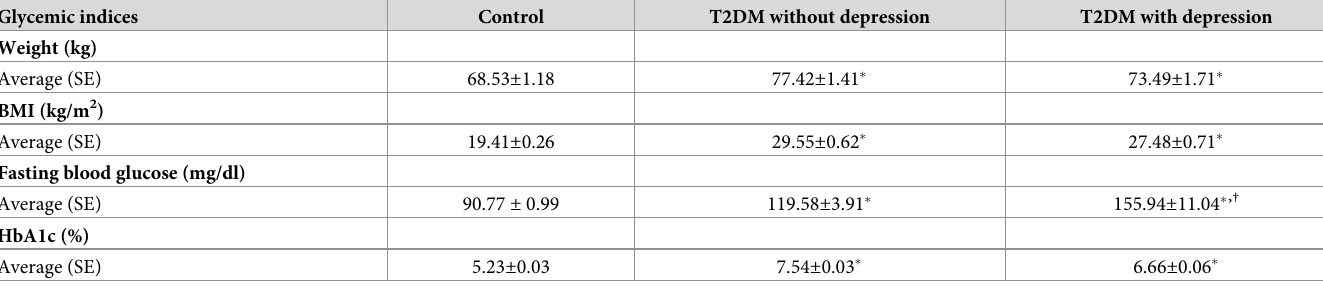
Table 2. Metabolic function of the control, type 2 diabetes, and type 2 diabetes with depression groups. Glycemic